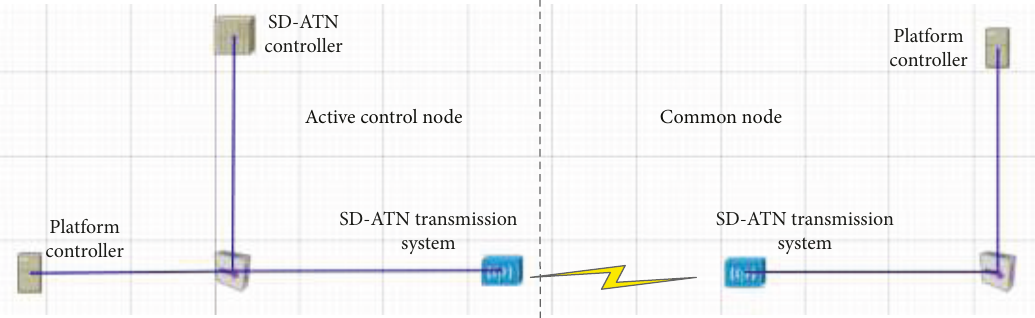
Figure 9: Example for simulation scenario.